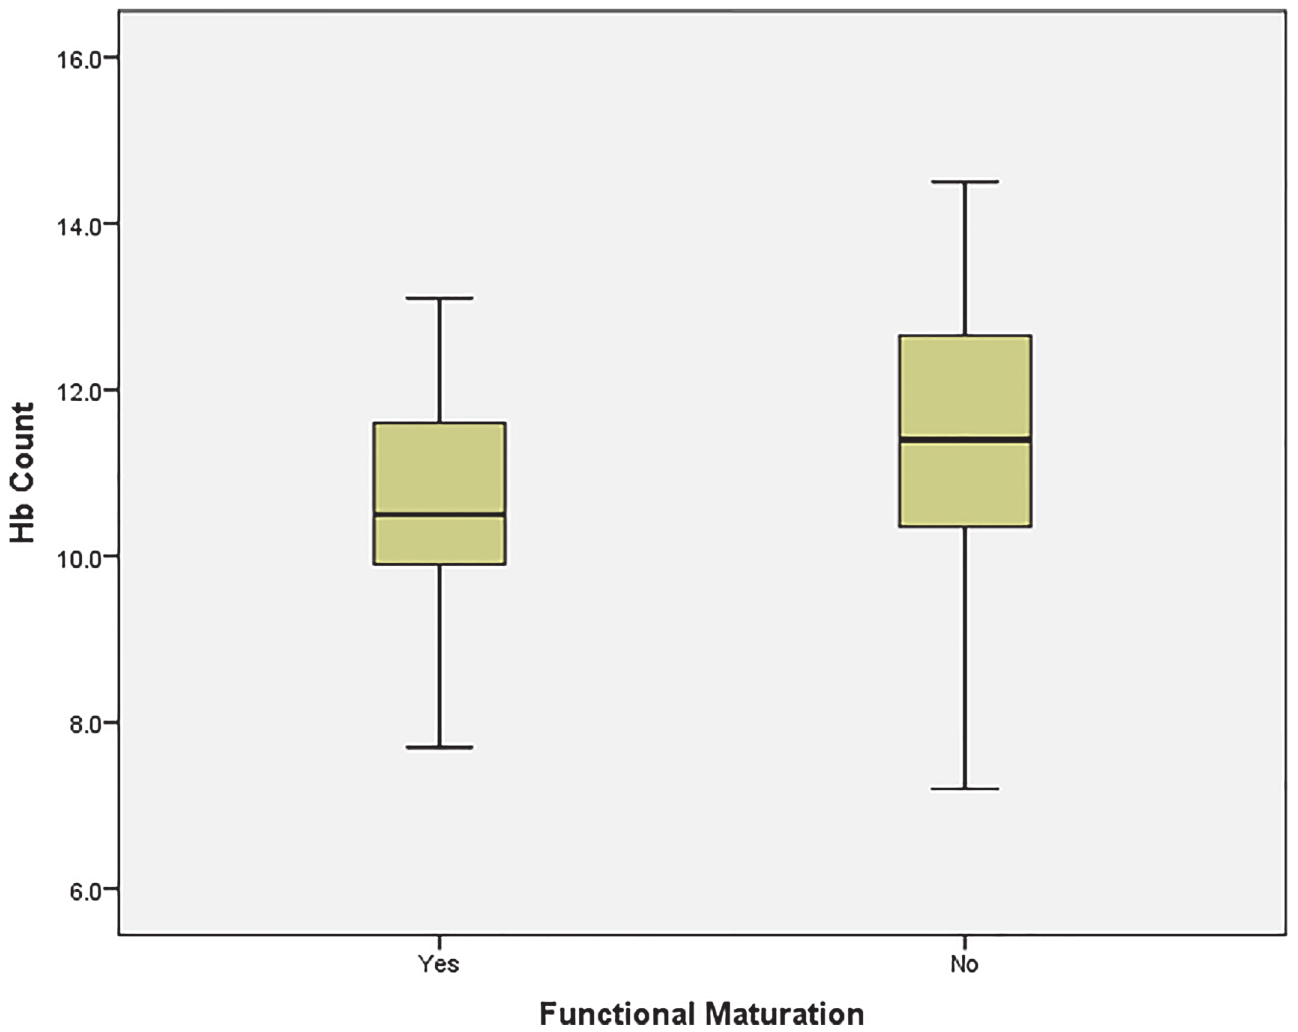
Fig 5. Variation in haemoglobin count between mature and non-mature AVF